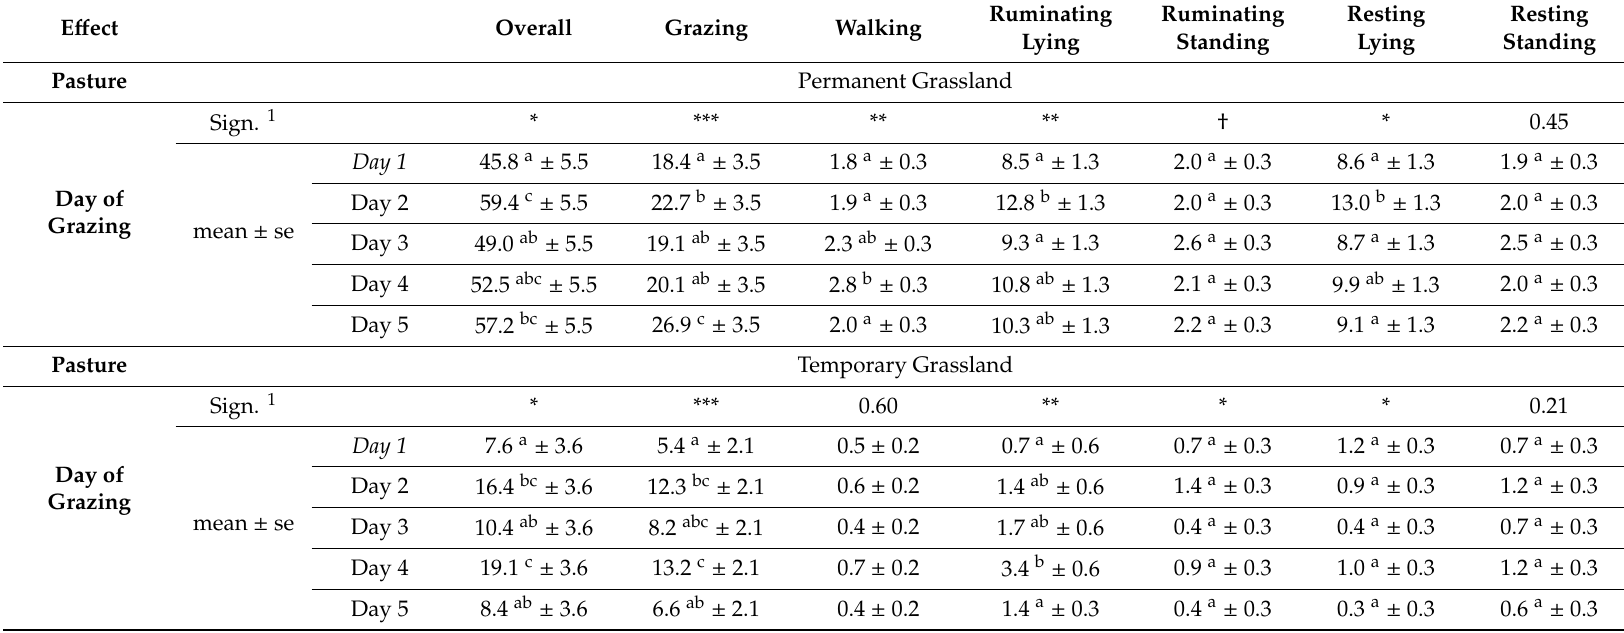
Ruminating Ruminating Resting Resting Lying Standing Lying Standing